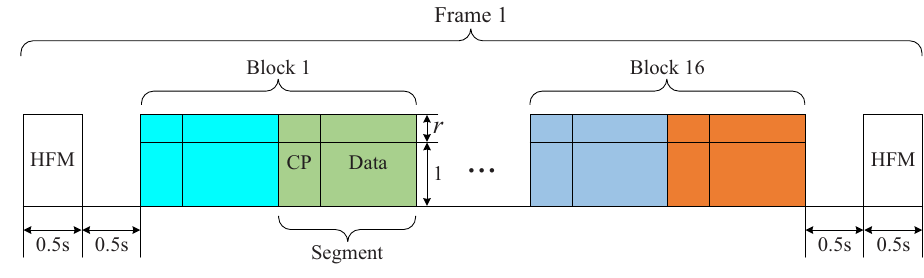
Figure 12. Signal structure for field experiments.